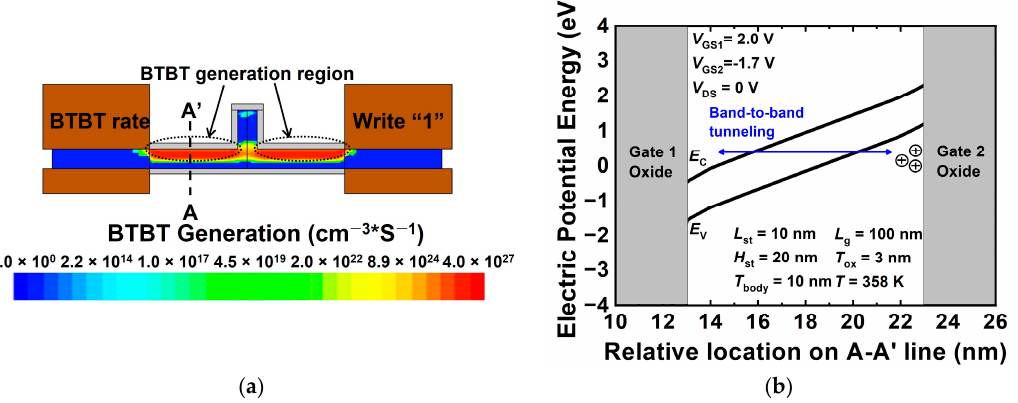
Figure 5. ( a ) Contour map of BTBT rate and ( b ) energy band diagram of the proposed 1T-DRAM cell in program operation (energy band is extracted 10 nm away from source–channel junction).